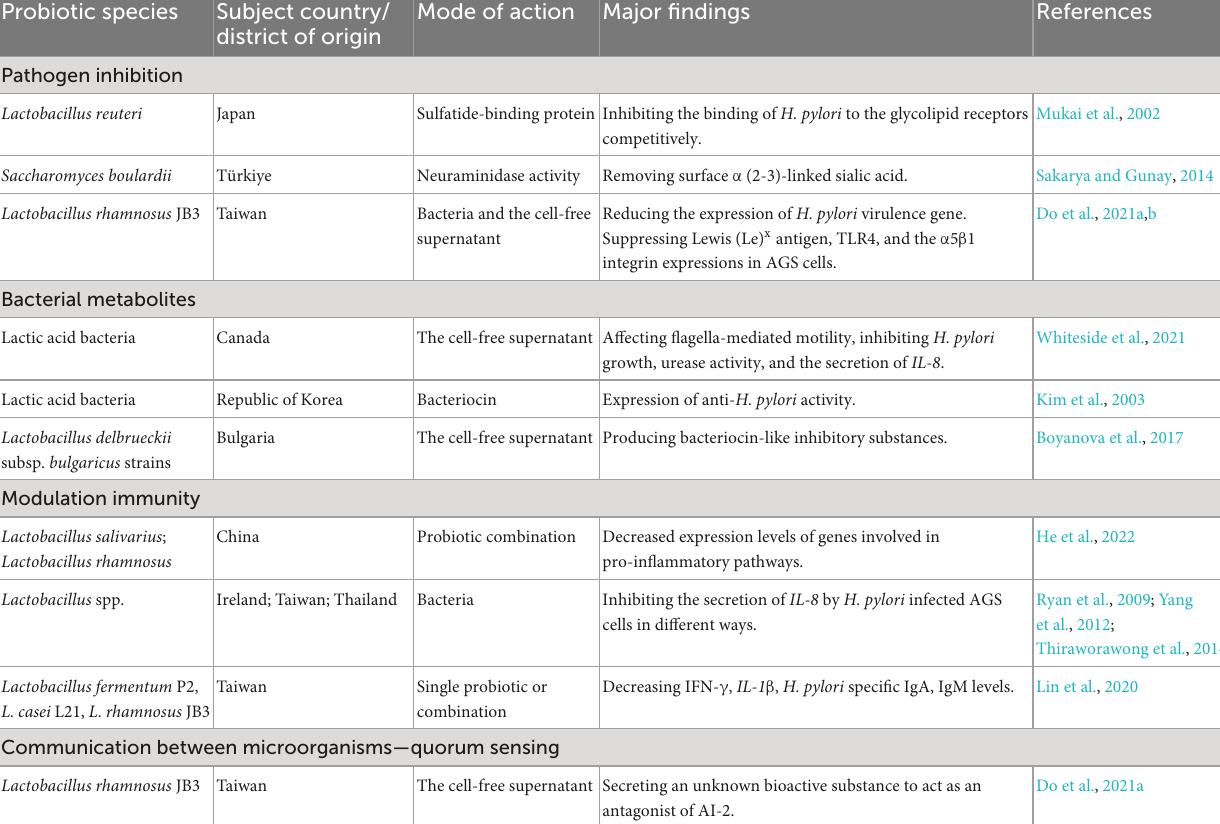
TABLE 2 The possible mechanisms of probiotics against H. pylori